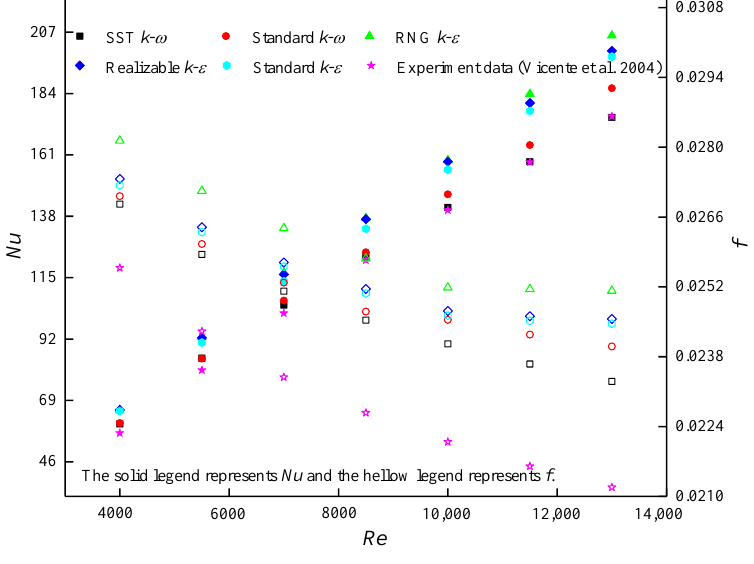
Figure 4. Numerical model validation